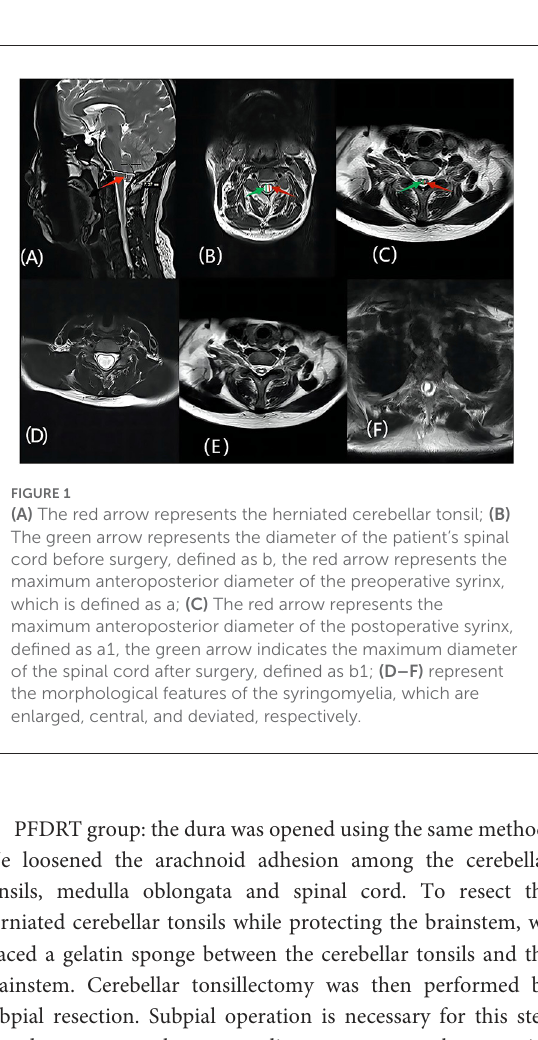
PFDRT group: the dura was opened using the same